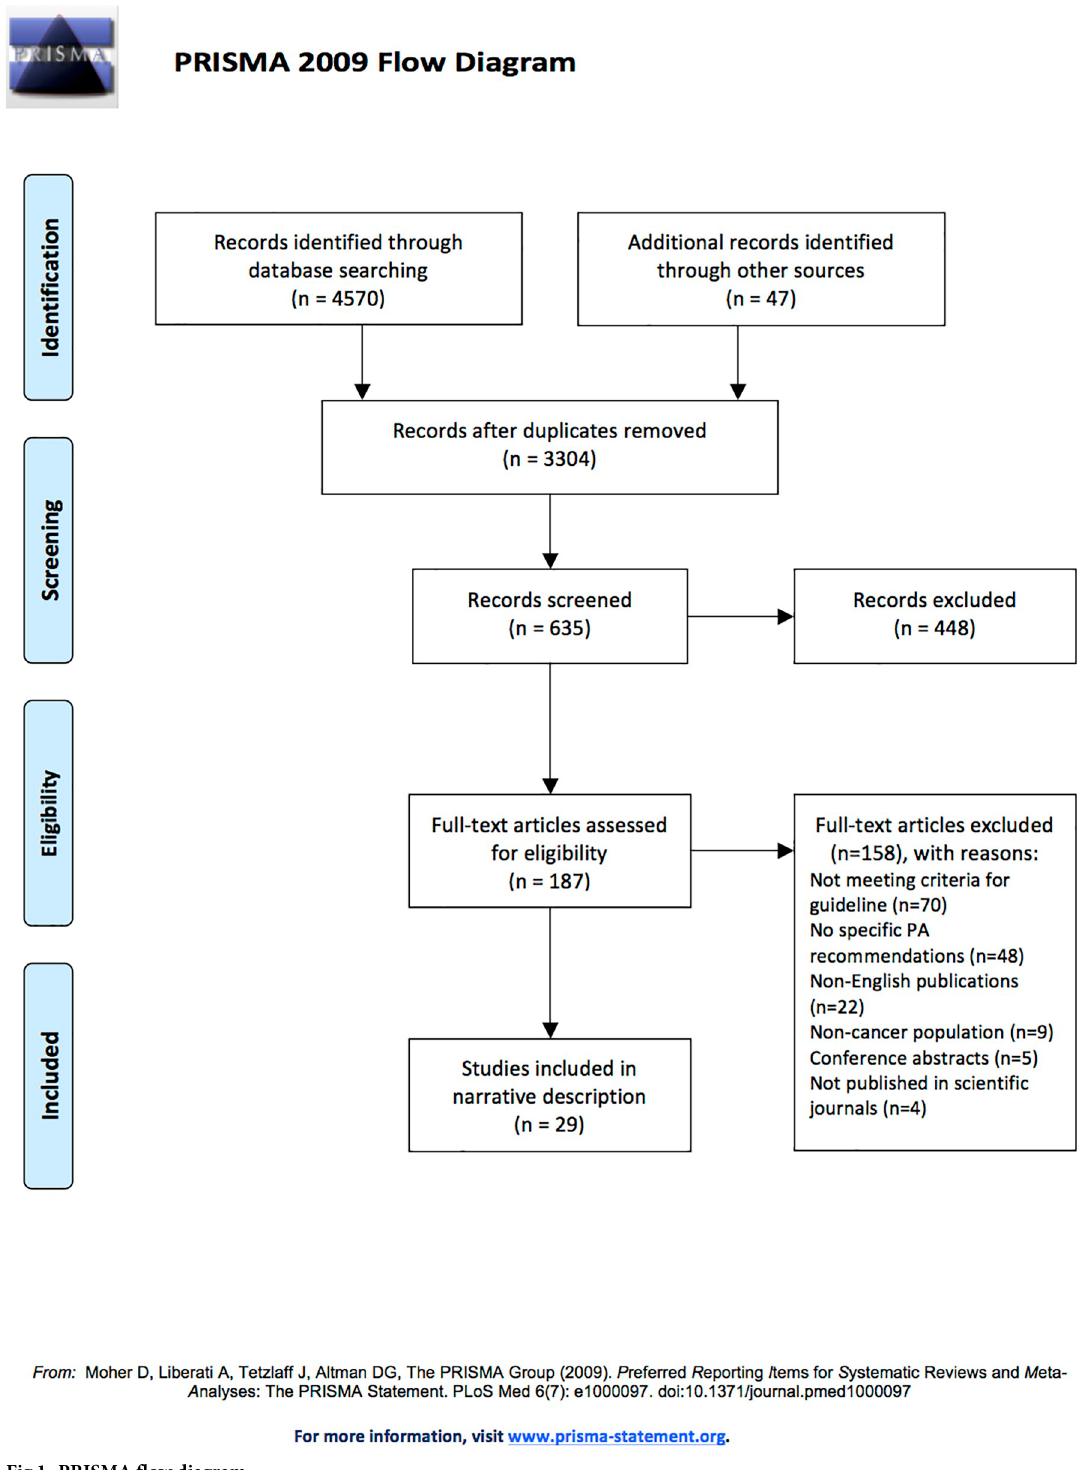
Fig 1. PRISMA flow diagram.